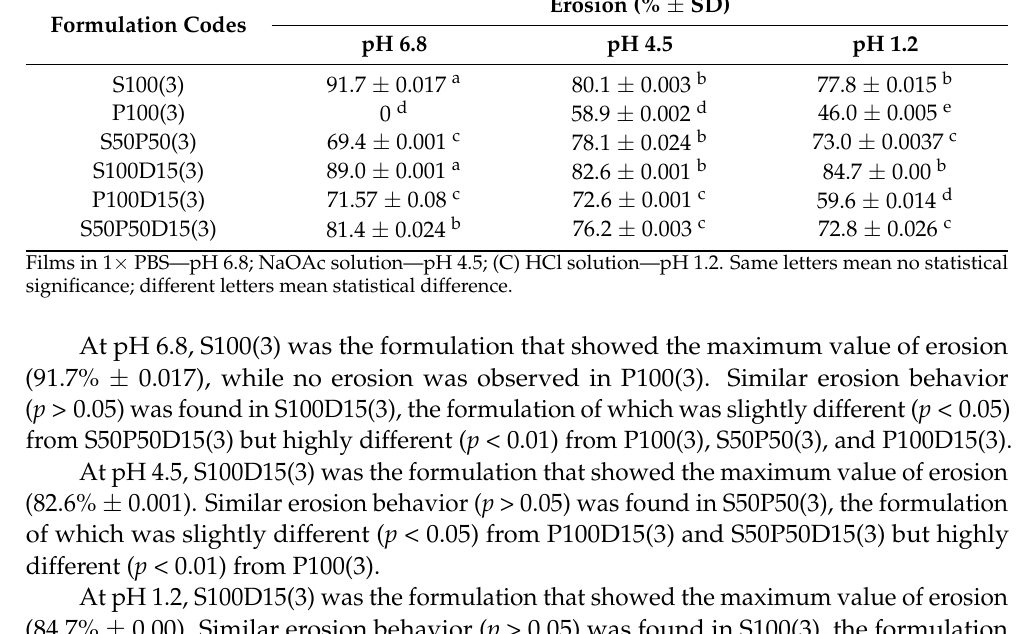
Table 3. Percentageoferosionofdrugloaded(andunloaded)SA/PVA-MMTclay-reinforcednanocomposite. Formulation